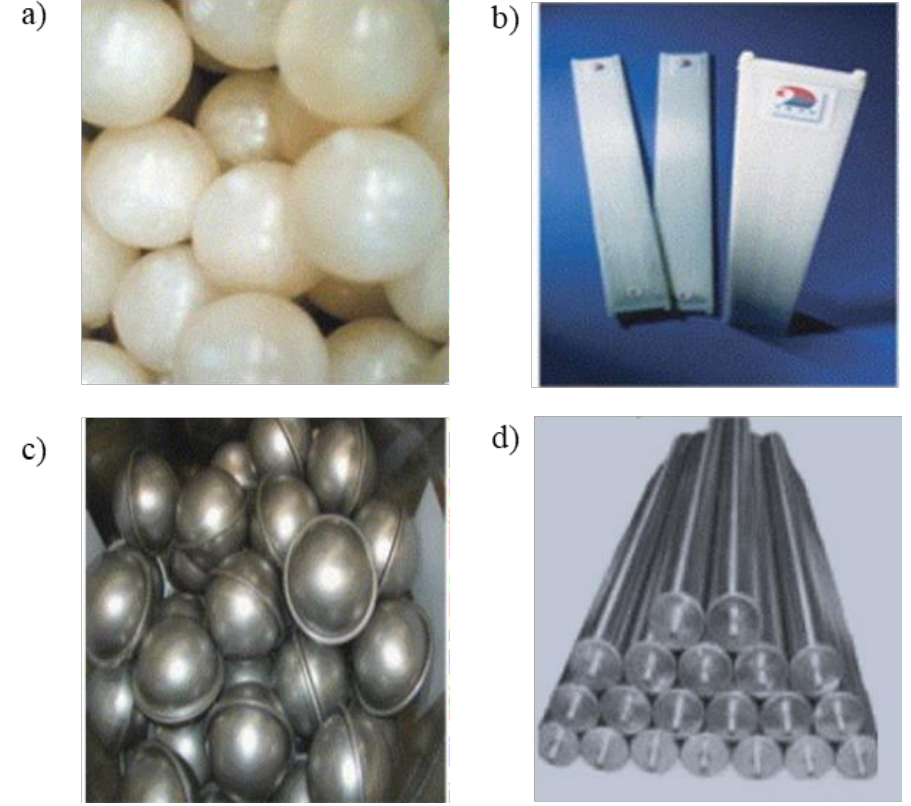
Figure 13. Commercially manufactured macro-capsules to store PCMs: ( a ) Polyolefin spherical balls, ( b ) Polypropylene flat panel, ( c ) stainless ball capsules, and ( d ) modules beam [36].